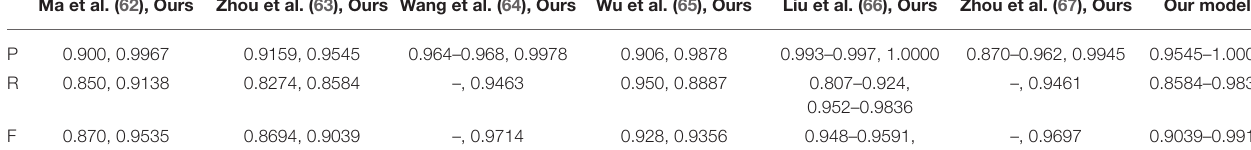
TABLE 10 | The evaluated segmentation results of Brain Tumor Segmentation (BraTS) datasets.